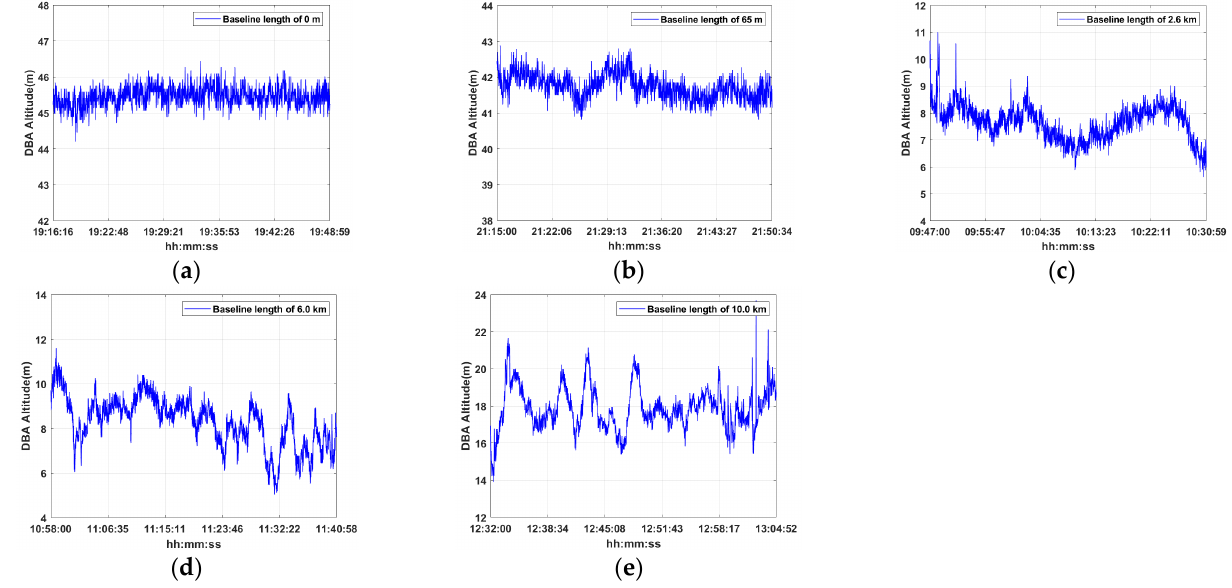
Figure 4. Time series of the DBA altitude results for five mobile station locations at different baseline lengths: ( a ) 0 m; ( b ) 65 m; ( c ) 2.6 km; ( d ) 6.0 km; ( e ) 10.0 km. Table 1. The DBA altitude statistical results of the five different baseline lengths (Unit: m).